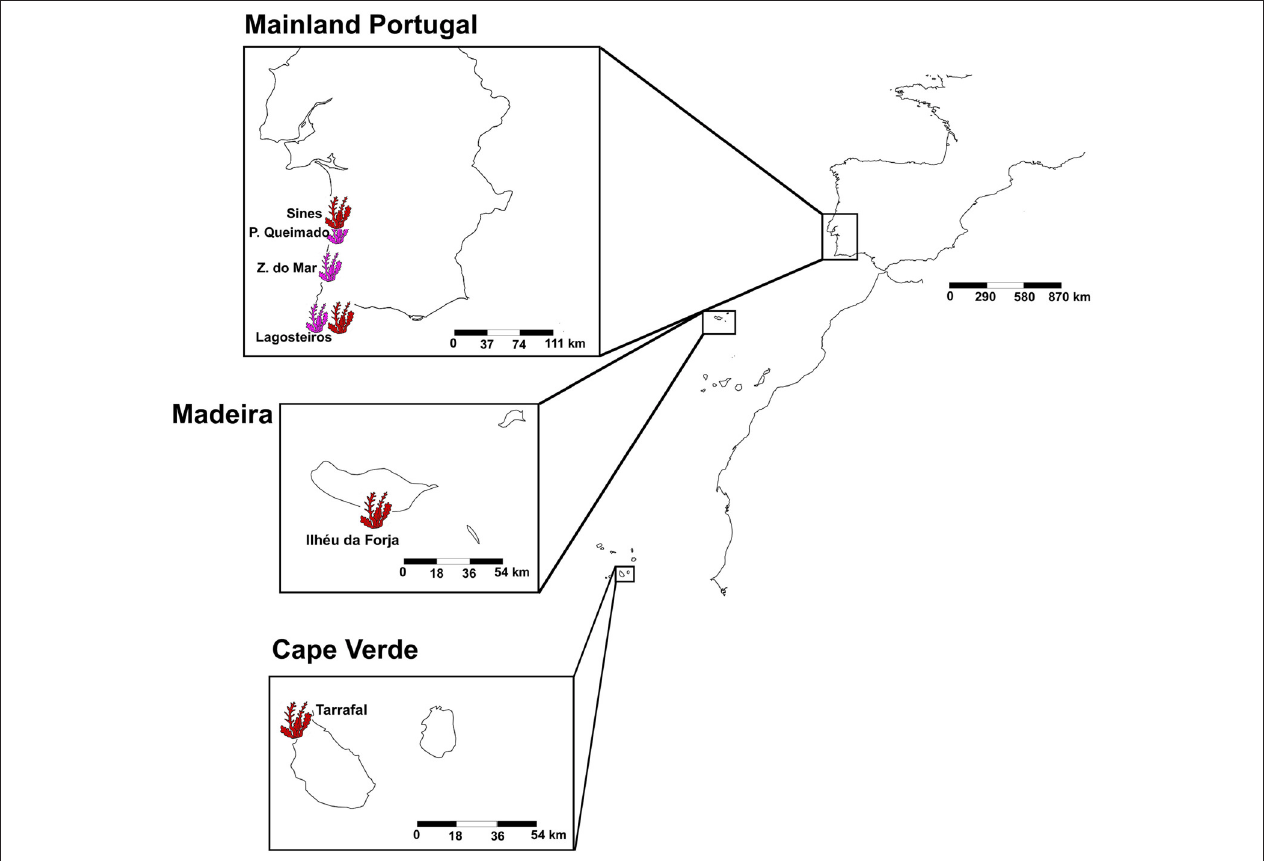
FIGURE 1 | Sampling locations of Asparagopsis taxiformis (in pink) and Asparagopsis armata (in red). Asparagopsis taxiformis was sampled in Ilhéu da Forja (Madeira Island), Sines and Lagosteiros (Mainland Portugal) and in Tarrafal Beach (Cape Verde). Asparagopsis armata was sampled in three mainland locations: Lagosteiros, Praia do Queimado, and Zambujeira do